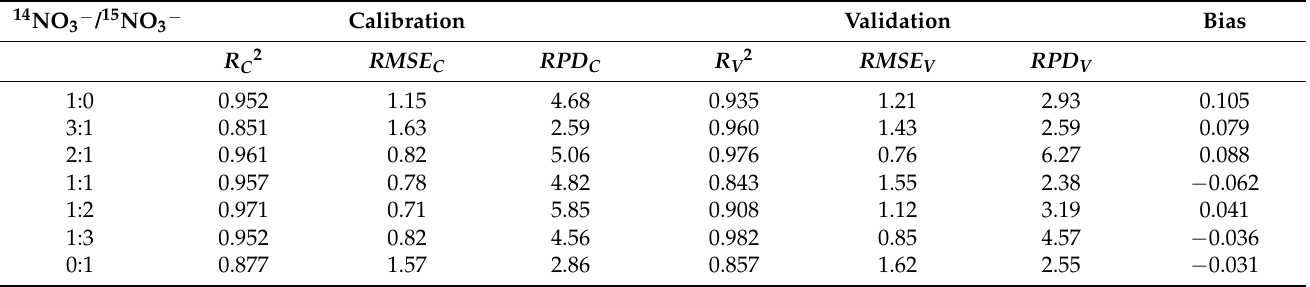
Figure 5. Distribution and model evaluation of the partial least squares regression (PLSR) principle component ( a , c , e , g , i , k , m ), training set (n = 20), and testing set (( b , d , f , h , j , l , n ); n = 7) of the PLSR prediction model based on deconvoluted spectra of 14 NO 3 − and 15 NO 3 − mixtures with different proportions ( 4 N/ 15 N, 1:0 ( a , b ); 3:1 ( c , d ); 2:1 ( e , f ); 1:1 ( g , h ); 1:2 ( i , j ); 1:3 ( k , l ); 0:1 ( m , n )). Table 2. Statistics of the PLSR models used in the calibration and validation sets for the prediction of 14 NO 3 − and 15 NO 3 − in mixtures with different proportions using deconvoluted spectra.